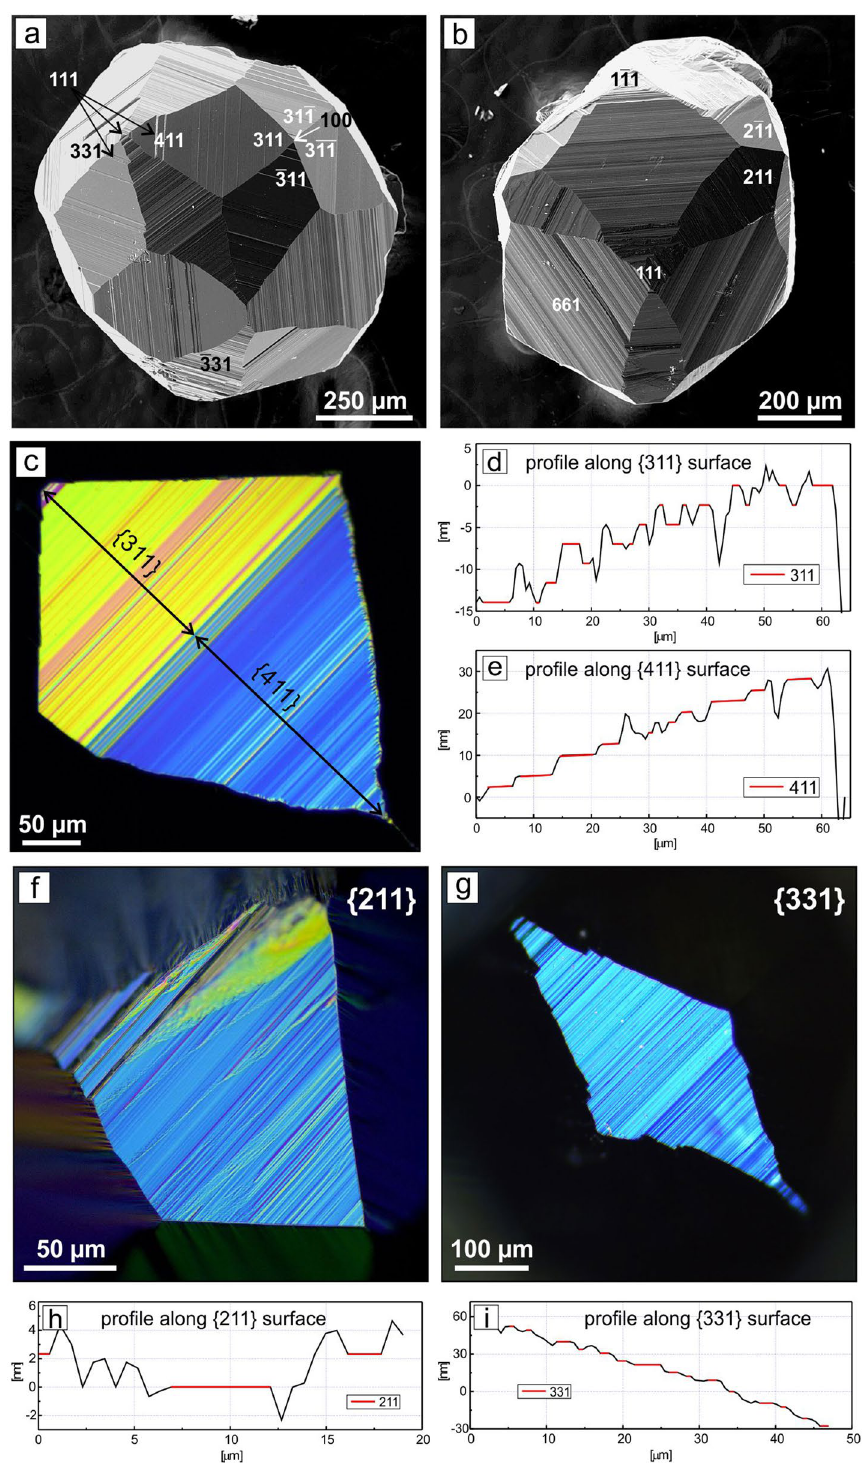
Figure 2. Morphology of combinational diamond crystals grown on the seeds. SEM micrographs of diamond crystals from ( a ) Er–C and ( b ) Lu–C systems; ( c ) DIC images of {311} and {411} faces and ( d, e ) profiles across these surfaces; ( f ) DIC image of the {211} face and ( h ) profile across it; ( g ) DIC image of the {331} face and ( i ) profile across it. Profiles were obtained using the TIC